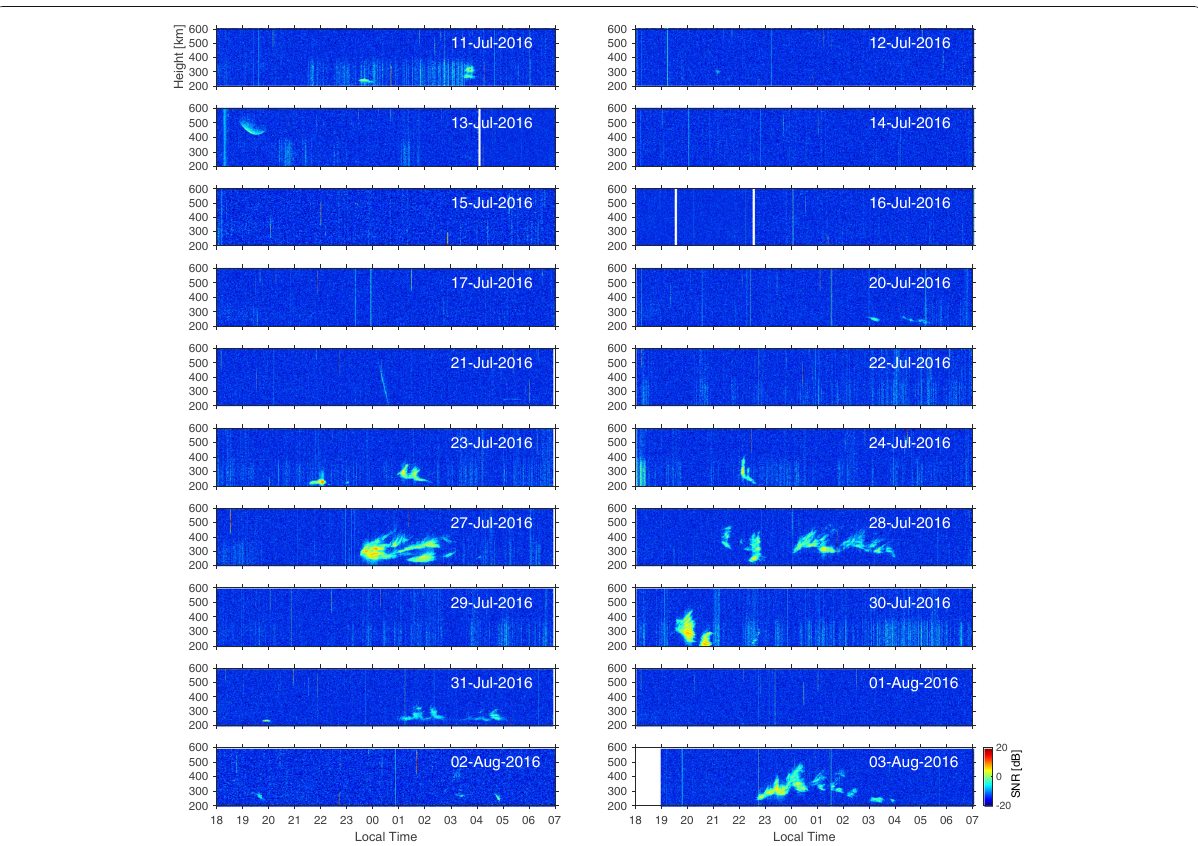
Fig. 1 Range-time-intensity (RTI) maps of the AMISR-14 observations made during the observation campaign (July 11–August 4, 2016). The RTI maps are for the vertical beam. The date in the upper right corner of each panel refers to the starting day of the